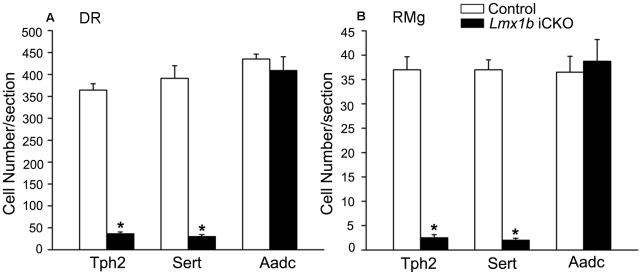
Decrease in numbers of Tph2- and Sert-labeled neurons in the dorsal raphe nucleus (DR) and raphe magnus nucleus (RMg).The number of neurons with intense in situ signals of Tph2 and Sert are significantly decreased in the DR (A) and RMg (B) of Lmx1b iCKO mice (n = 4; * P<0.05), while the number of Aadc positive cell is comparable in Lmx1b iCKO mice and wild-type mice (n = 4, P>0.5).